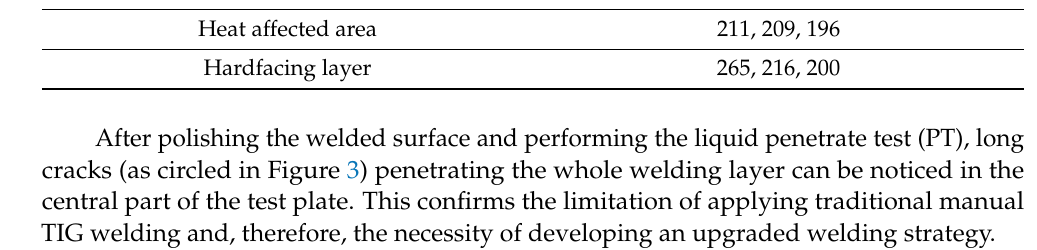
Table 5. Elementary composition of the melt zone (wt.%).